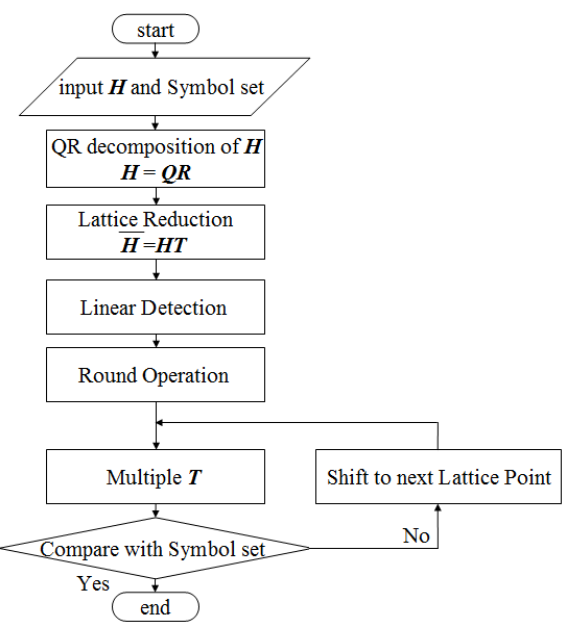
Fig. 5. Received signal (red circle mark) and search integer coordinate set a (red asterisk).